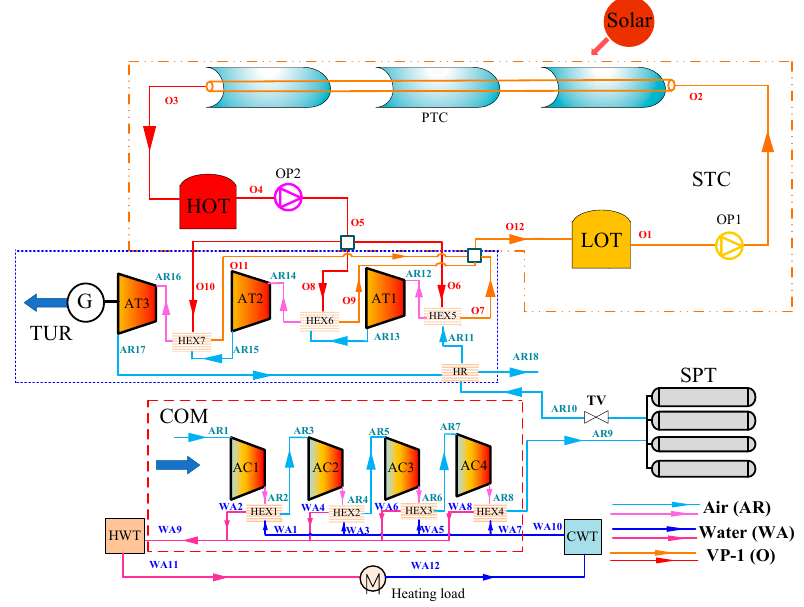
Figure 1. The design scheme of ST-CAES.